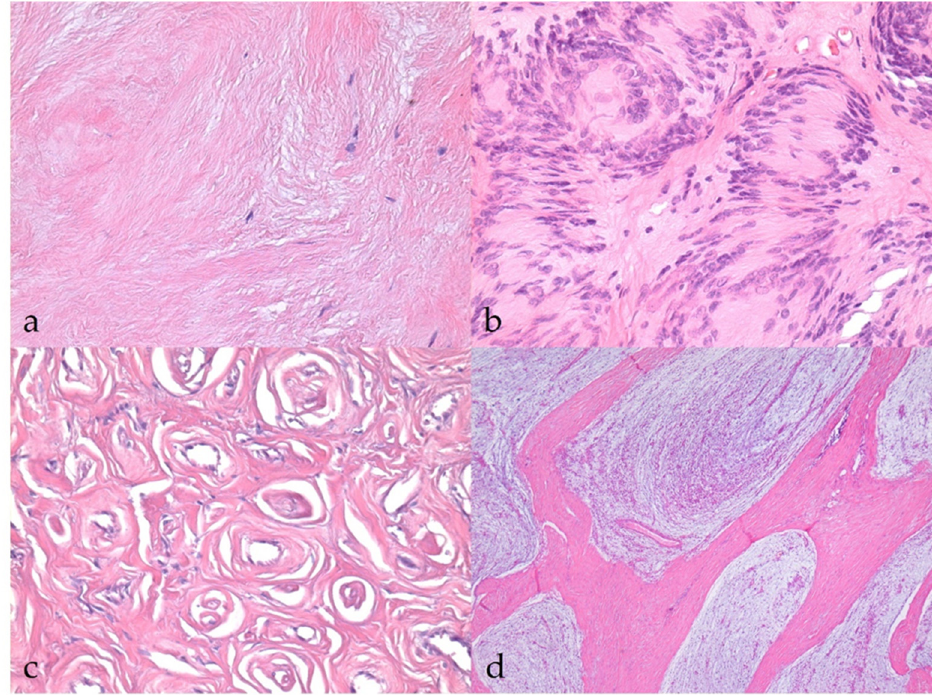
Figure 1. Histopathological characteristics of benign nerve sheath tumors (BNSTs). ( a ) Abundant collagenous stroma in the neurofibroma with the so-called ‘‘shredded carrot’’ appearance (case no. 17). HE, 400×. ( b ) Classic schwannoma with marked nuclear palisading (Verocay bodies) (case no. 10) HE, 400×. ( c ) Concentric arrangement of neoplastic perineurial cells, forming so-called pseudo-onion bulbs in the perineurioma regions of hybrid NST (case no. 23). HE, 400×. ( d ) Nerve sheath myxoma consisting of myxoid lobules separated by distinct collagenous septa (case no. 38). HE, 40×.